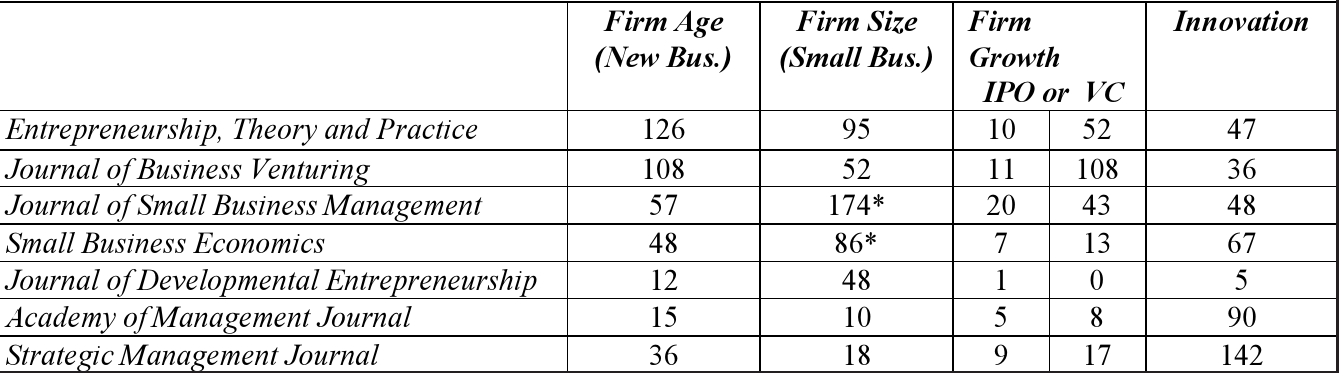
Table 1. Search Results in Business Source Premier for Screening Criteria (April 3, 2006)